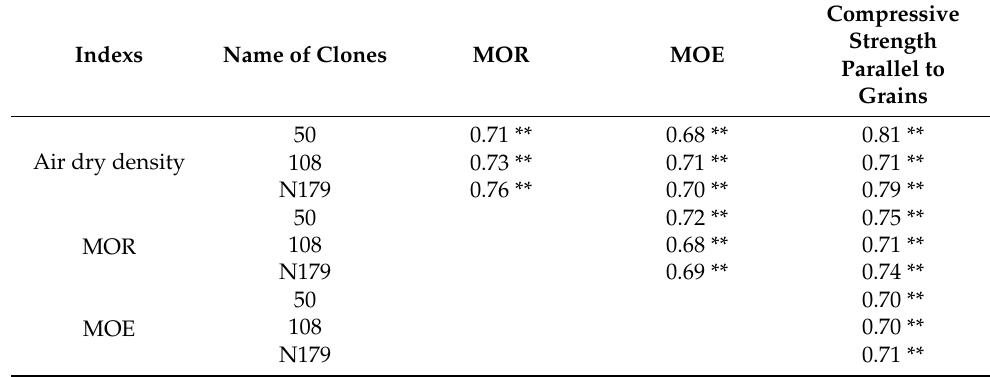
Table 6. Correlation between the mechanical properties and air dry density of three poplar clones.